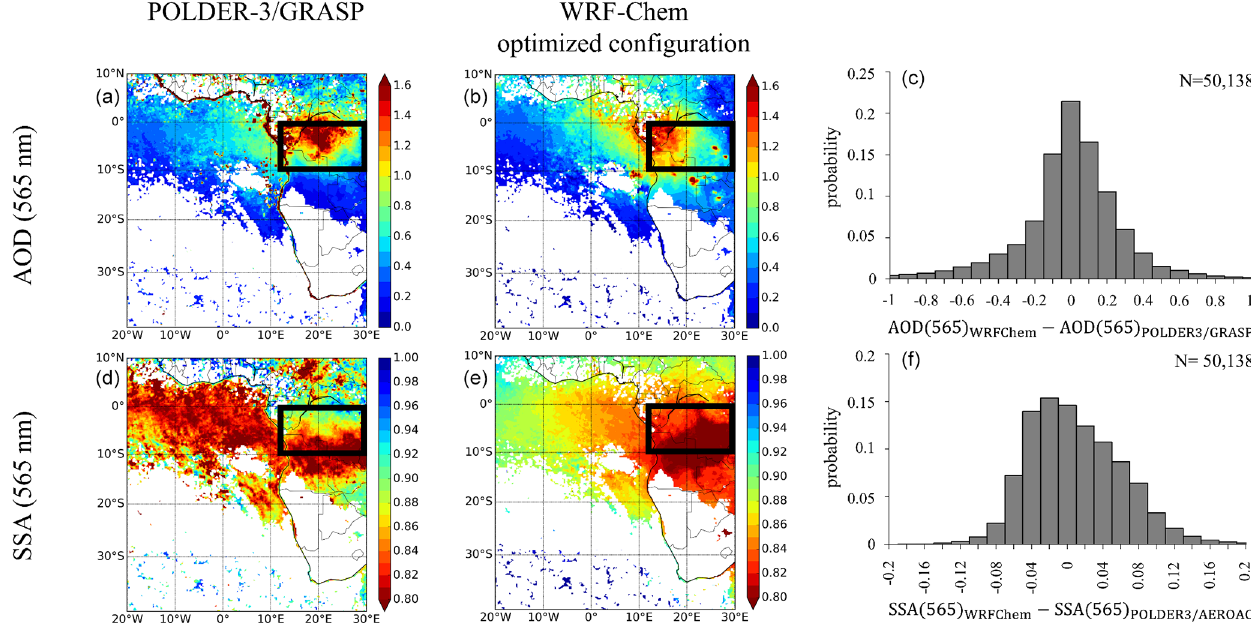
Figure 16. Comparison of monthly averaged AOD (a, b) and SSA (d, e) at 565nm in clear sky retrieved by POLDER-3/GRASP (a, d) and simulated with the WRF-Chem optimized configuration (b, e) over the southeast Atlantic region for July 2008, with the associated histograms of differences between the model and the satellite observations over the whole domain (c, f) . The black frames (12–30 ◦ E, 10–0 ◦ S) represent the area of